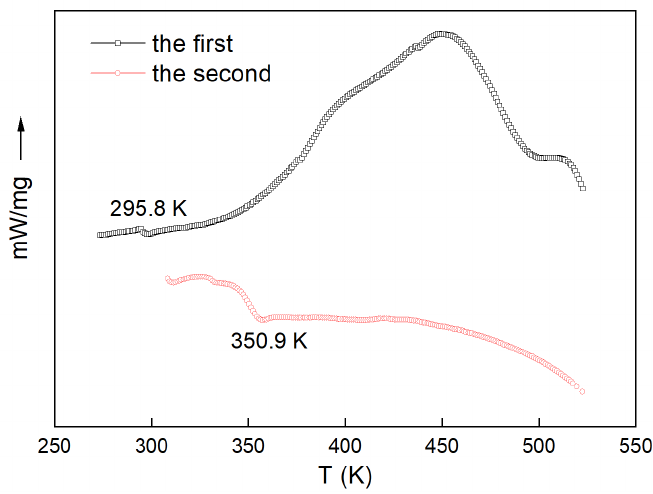
Figure 1. The first and second DSC scanning curves for the H 6 XDI/BES